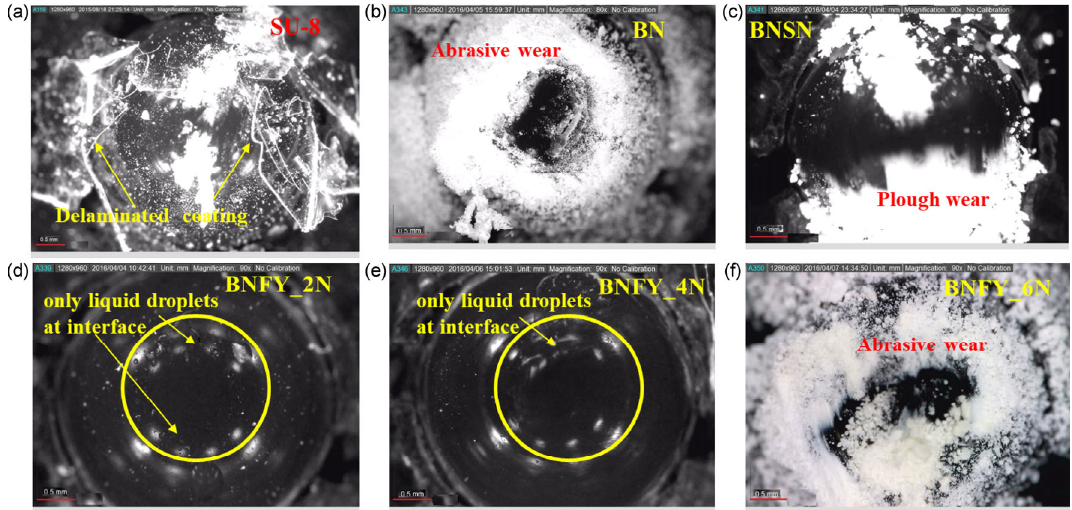
Fig. 11 Portable microscope images of the ball after the tribology test: (a) SU-8 at 2 N, (b) BN at 2 N, (c) BNSN at 2 N, (d) BNFY at 2 N, (e) BNFY at 4 N, and (f) BNFY at 6 N. All tests were carried out at a constant sliding speed (0.28 m/s). The scale is 0.5 mm in each